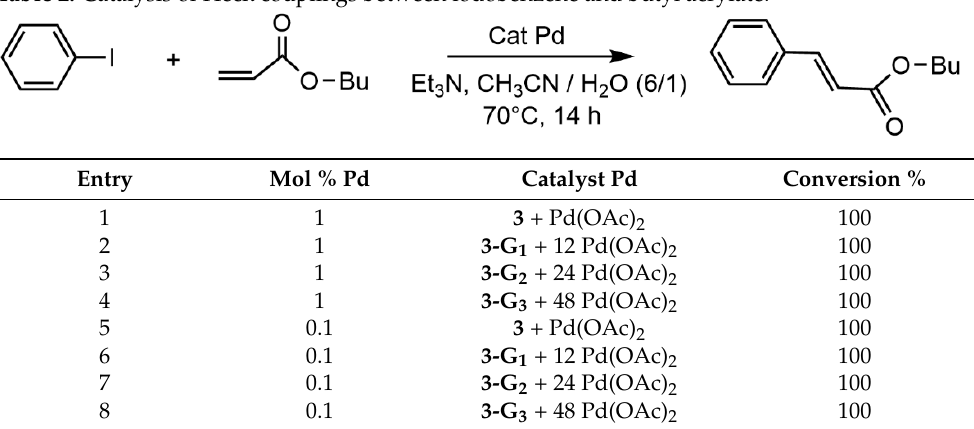
Table 2. Catalysis of Heck couplings between iodobenzene and butyl acrylate.